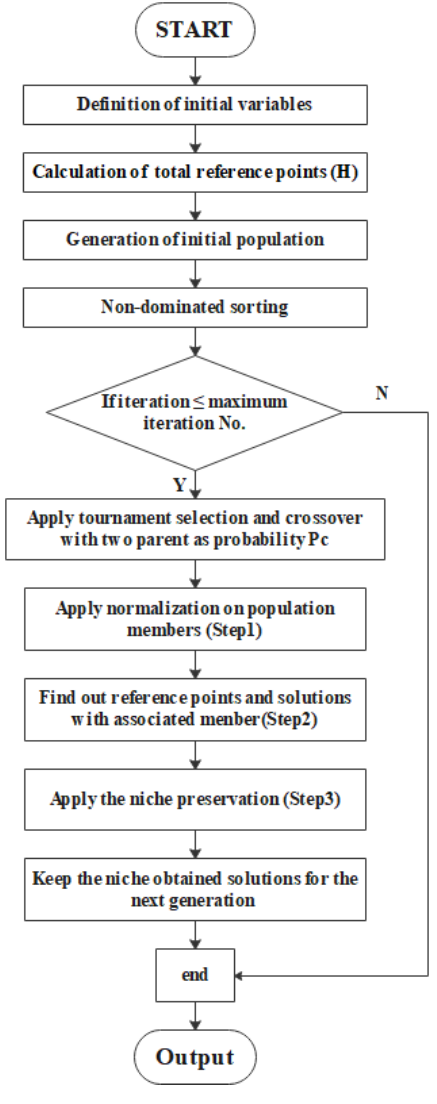
Figure 6. Algorithm flow of NSGA-III.